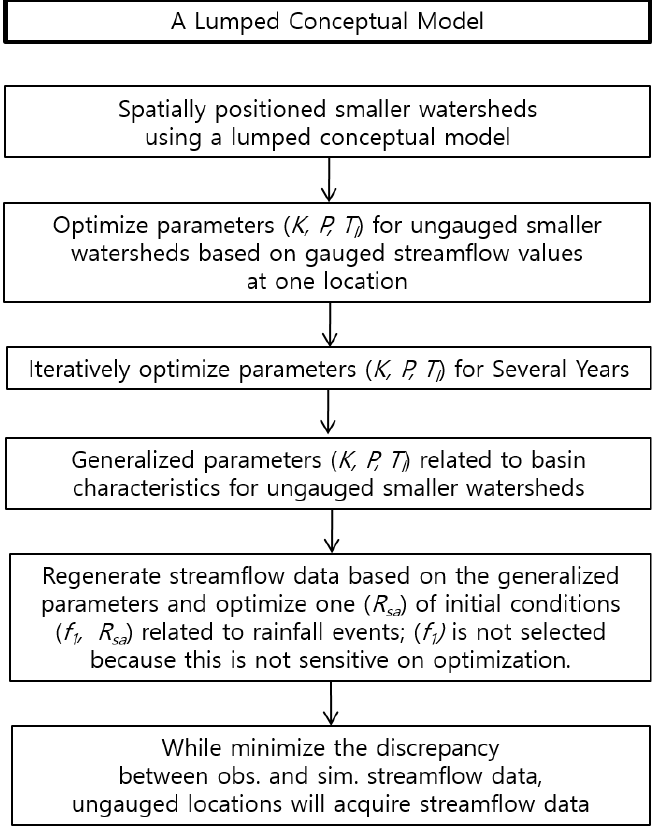
Figure 4. Spatial propagation procedure [15].